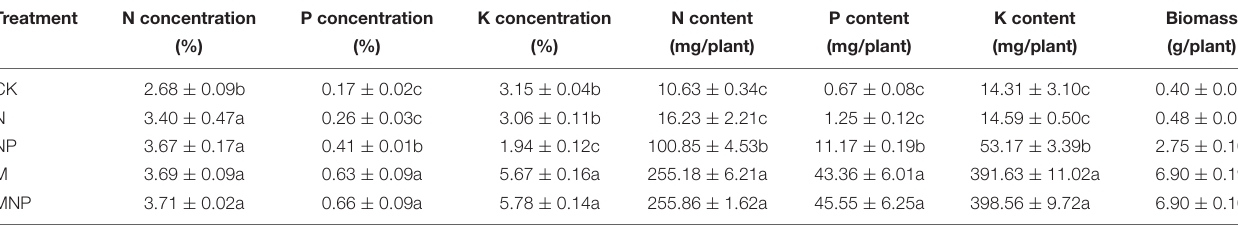
TABLE 2 | Plant nutrient content and biomass.